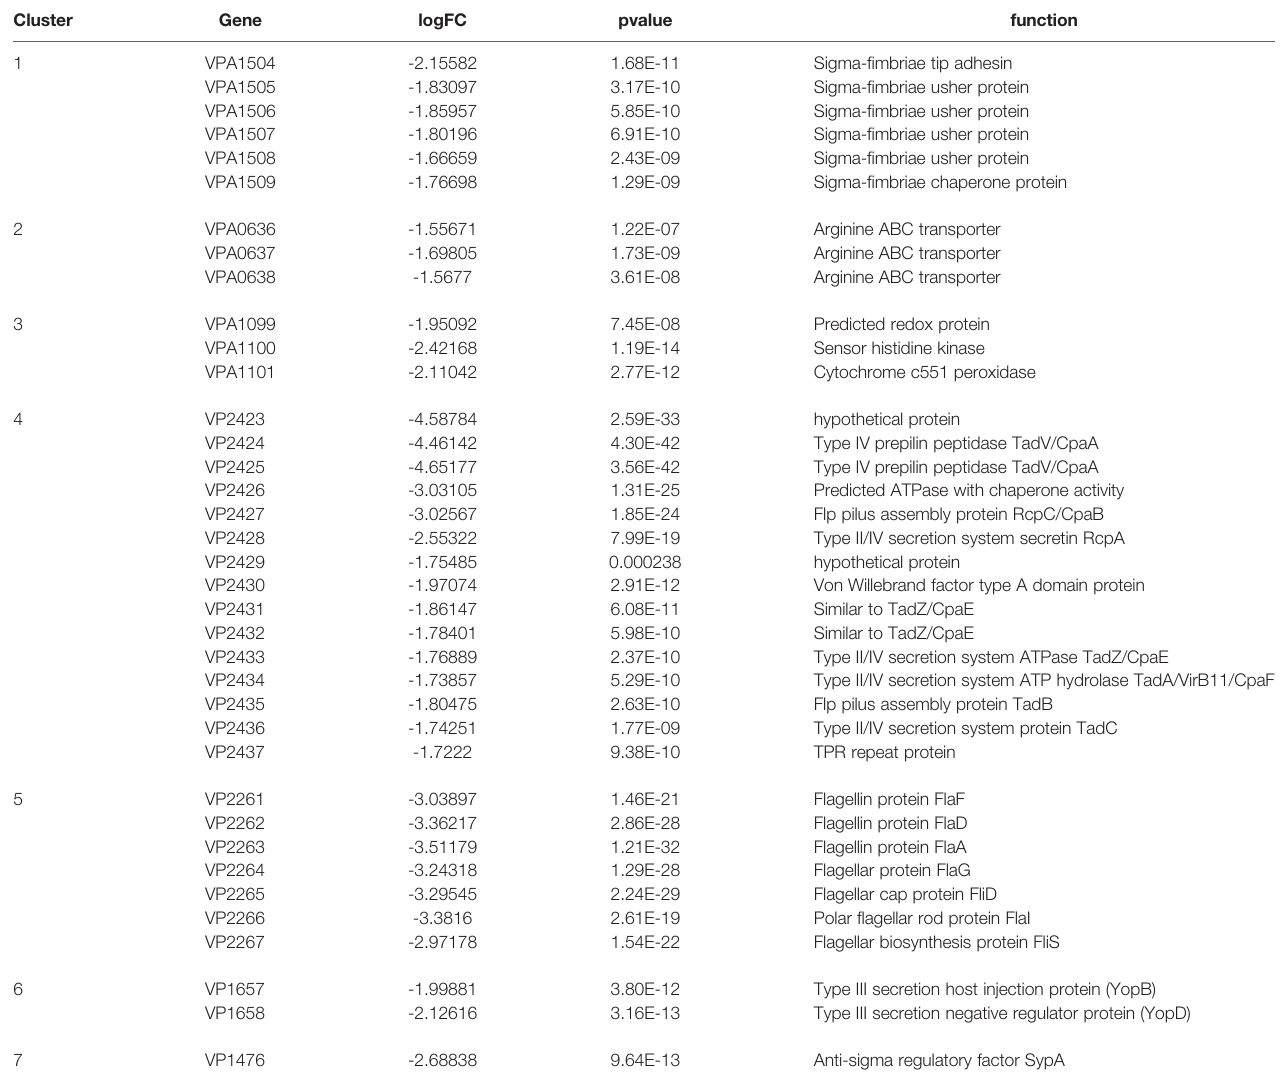
TABLE 4 | Genes down-regulated (> 1.5-fold change) in the mutant